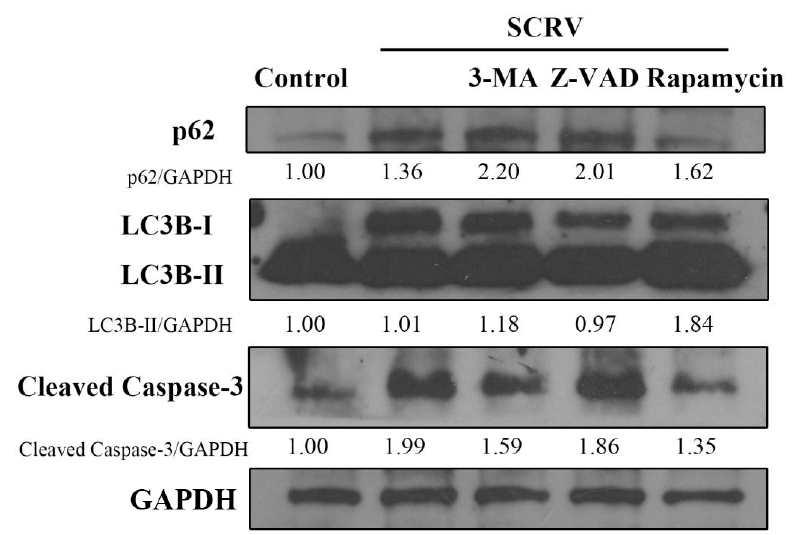
Figure 4. Effects of different chemicals (3-MA, Z-VAD and rapamycin) on the expression of p62, LC3 and caspase-3. Western blotting analysis showed that rapamycin could reduce the expression level of p62 and caspase-3 in SCRV-infected EPC cells at 24 h. GAPDH was used as internal control.